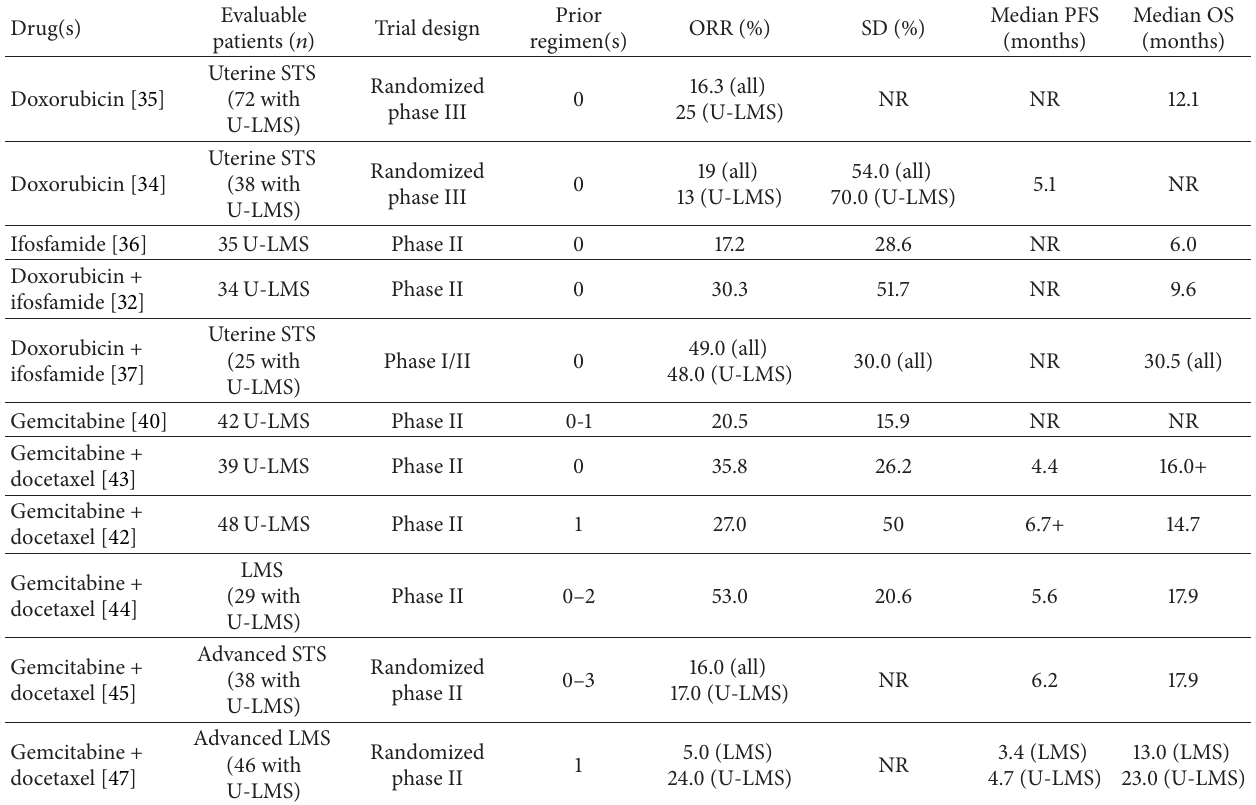
Table 1: Summary of efficacy results of active chemotherapy regimens in uterine leiomyosarcoma (for trabectedin data see Table 2).